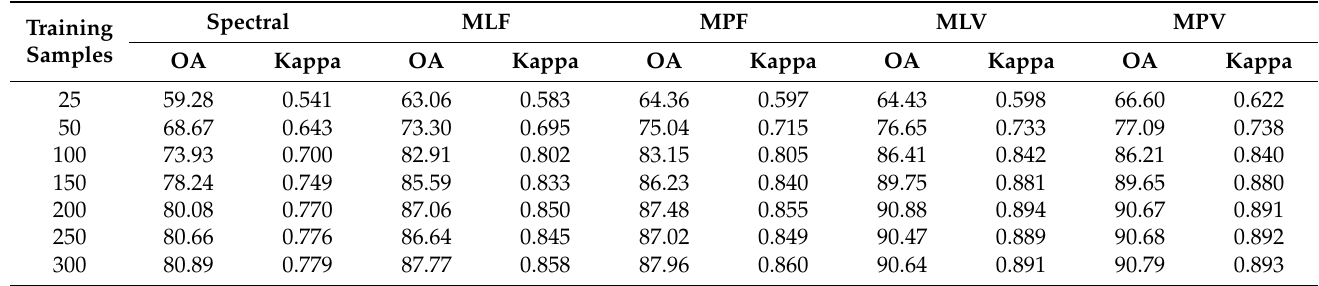
Table 5. OAs (%) and Kappa coefficients obtained by different methods for the Hanchuan dataset using SVM with different numbers of training samples per class.